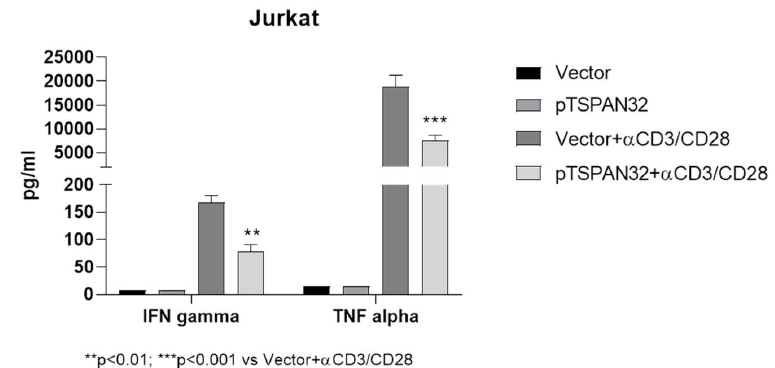
Figure 4. E ff ect of TSPAN32 overexpression in Jurkat cells. Following transient transfection of Jurkat cells with a DNA plasmid encoding for TSPAN32 (pTSPAN32) or the empty plasmid, cells were stimulated with anti-CD3 / CD28 for 24 h and the concentrations of TNF-alpha and IFN-gamma in the supernatant were determined by ELISA. Data are shown as normalized mean ± SD and statistical analysis performed using one-way ANOVA followed by Bonferroni multiple test correction.